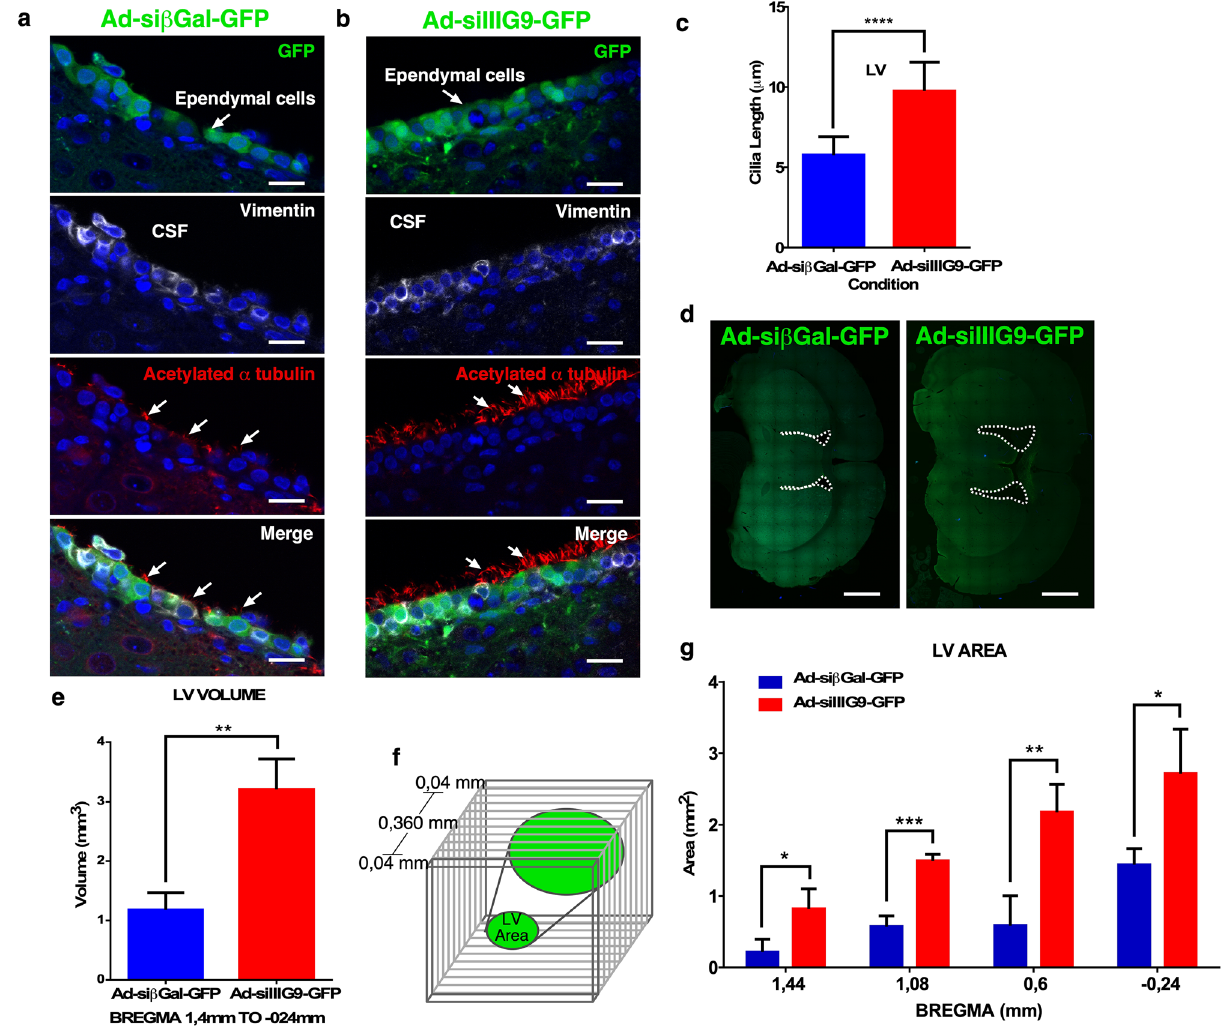
Figure 5. Loss of IIIG9 function in ependymal cells induced greater ciliary length and ventriculomegaly. ( a ) Ad-siβGal-GFP expression and immunohistochemistry analysis. Ependymal cell layer expressing GFP, vimentin and acetylated α-tubulin. Ependymal cells with cilia (arrows), suggesting a reverse stroke position (lying down). ( b ) Ad-siIIIG9-GFP expression and immunohistochemistry analysis. Ependymal cell layer expressing GFP, vimentin and acetylated α-tubulin (arrows). Ependymal cells with cilia (small arrows), suggesting a forward stroke position (straight). ( c ) Quantification analysis of cilia length observed in ependymal cells from the lateral ventricle area in Ad-siIIIG9-GFP-injected animals compared to the controls. ( d ) Tile-scan imaging of brain slices from Ad-sibGal-GFP- or Ad-siIIIG9-GFP-injected animals. Representative dotted lines define the lateral ventricle area observed in control or Ad-siIIIG9-GFP-injected animals. ( e ) Lateral ventricle volume analysis in control or Ad-siIIIG9-GFP-injected animals. ( f ) Schematic representation of the quantification method and the selection of brain sections. ( g ) Lateral ventricular area quantification in different brain bregma positions. All images are representative of different biologically independent samples. CSF cerebrospinal fluid. ( a , b ) n = 4. ( d ) n = 4. ( c ) Data are shown t-student (two-tailed) as mean ± SEM; all data are representative of four separate experiments. **** P < 0.0001. ( e – g ) Data are shown t-student (two-tailed) as mean ± SEM; all data are representative of four separate experiments. * P < 0.05, ** P < 0.01, *** P < 0.001. Scale bars = ( a , b ) 20 μm; ( d ) 1 positive for GFP but negative for IIIG9 (Fig. 6d, red and green channels and arrowheads in inset). In turn, cells positive for IIIG9 (red signal) were negative for GFP (Fig. 6d, red and green channels and long arrows in inset). To analyze the presence of microglia/macrophages in regions with tissue damage, we used the microglial marker IBA-1 (Fig. 7), which was detected in the areas with astrogliosis in Ad-siIIIG9-GFP-treated animals (Fig. 7b, arrows) compared with controls (Fig. 7a, arrows). In control animals, microglia were detected in the subependymal region, but the cells were observed to have fine processes, similar to nonactivated microglia (Fig. 7a, red channel and inset). Conversely, microglia that were detected in the astrogliosis region had thicker processes, showing an activated phenotype (Fig. 7b, red channel and insets). In regions with vimentin-positive cells, the microglial density was even higher, showing a diffuse pattern of IBA1-positive processes (Fig. 7b,